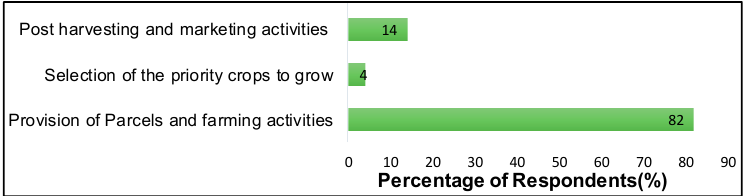
Figure 9. Level of farmers’ participating in LUC (based on the household survey).